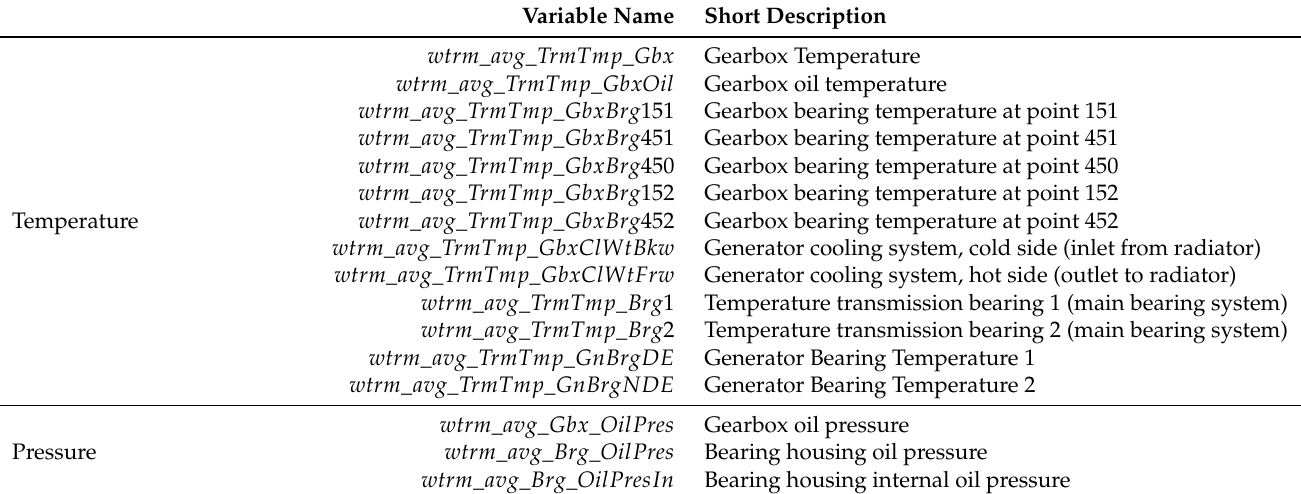
Table 3. Temperature and pressure measurements collected in the transmission subsystem with a brief explanation. The measurements are 5-min